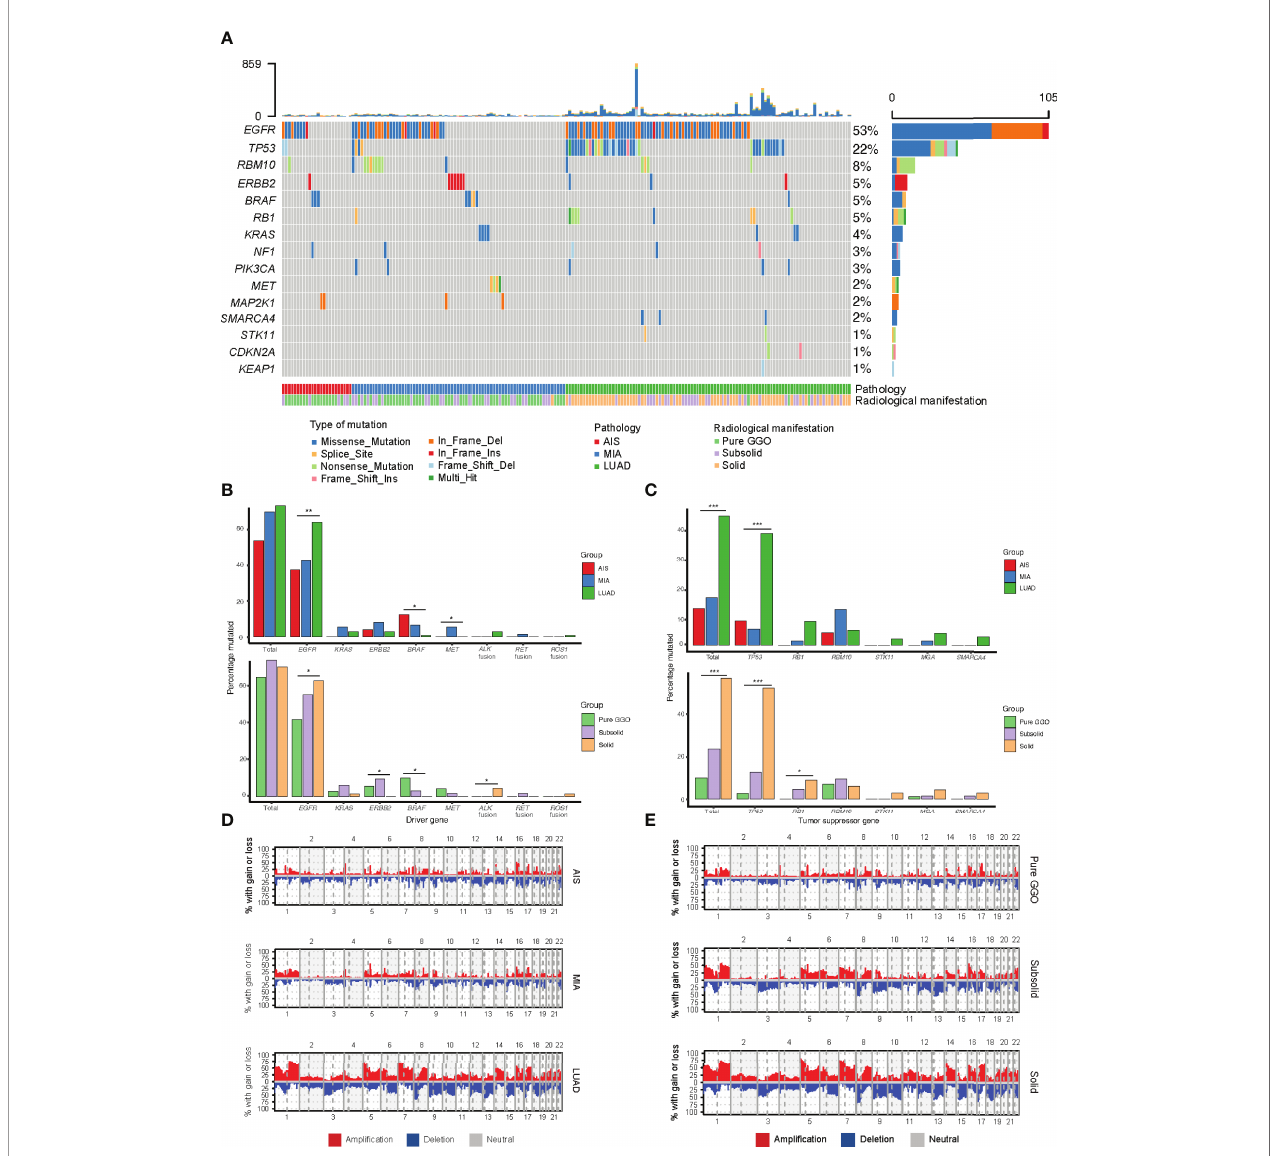
FIGURE 2 | Comparison of genomic alterations for different pathological and radiological groups. (A) Waterfall plot showing the landscape of genomic alterations in each group. (B) Comparison of mutation frequency in major driver genes among different groups. (C) Comparison of mutation frequency in major tumor suppressor genes among different groups. (D) Comparison of somatic copy number alterations among different pathological groups. (E) Comparison of somatic copy number alterations among different radiological groups. *, p<0.05; **, p<0.01; ***,